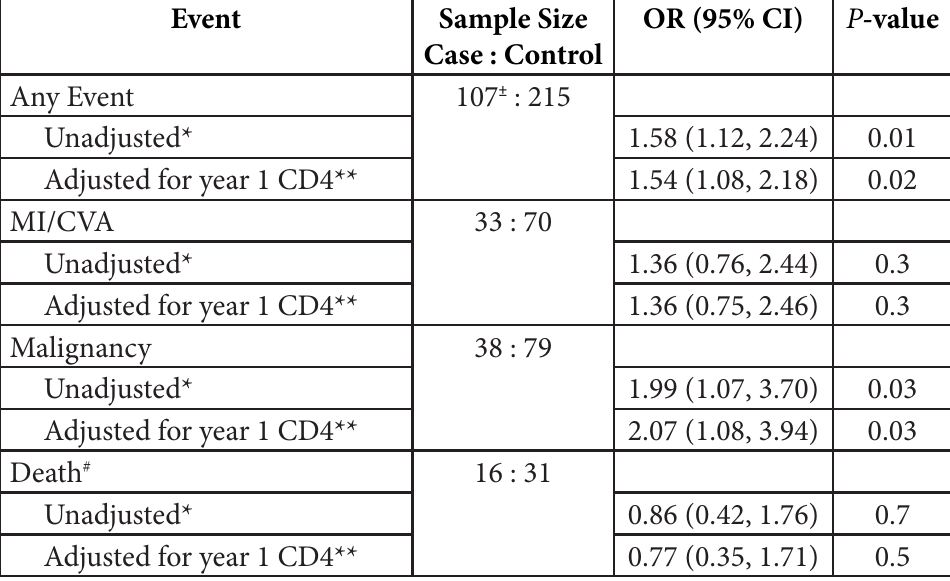
Table 2. Association between Year 1 CMV IgG Level and Non-AIDS